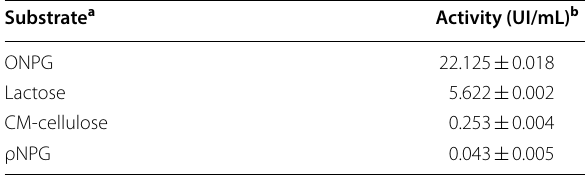
a ONPG: o -nitrophenol-β- d -galactopyranoside; ρNPG: ρ-nitrophenol-β- d - galactopyranoside; CM-cellulose: carboxymethyl celulose; Lactose: β- d - galactopyranosyl-(1 4)- d -glucose → b One unit (U) of β-galactosidase activity was defined as the amount of